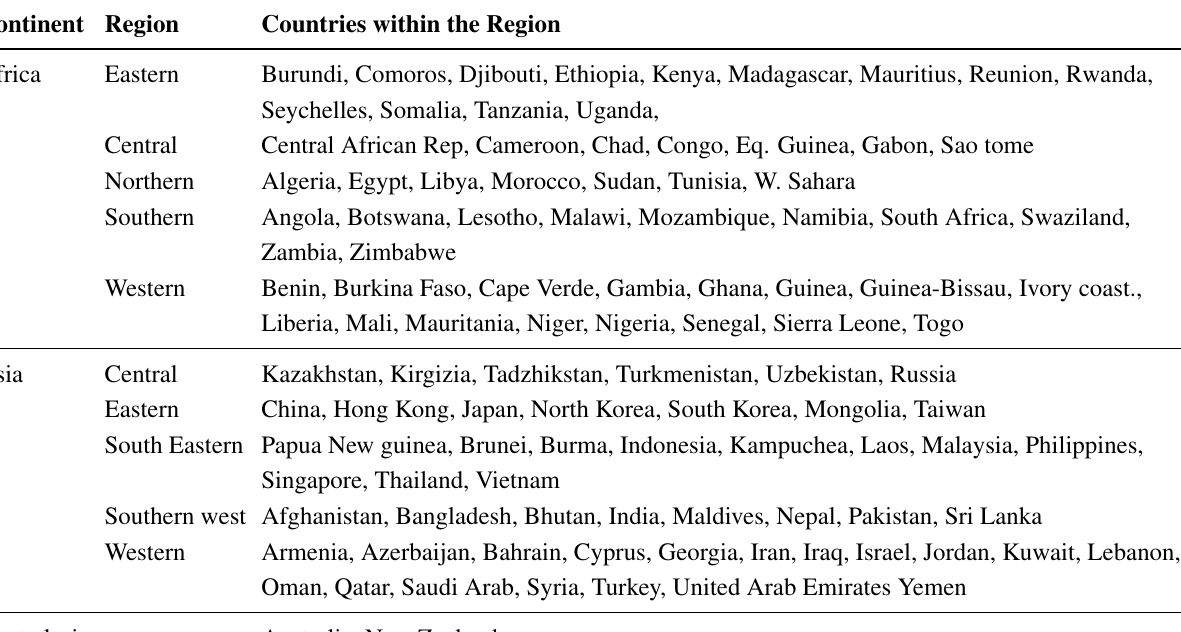
Table 4. Global Regional Groupings of the Countries according to UNEP(2009), after [17]. Continent